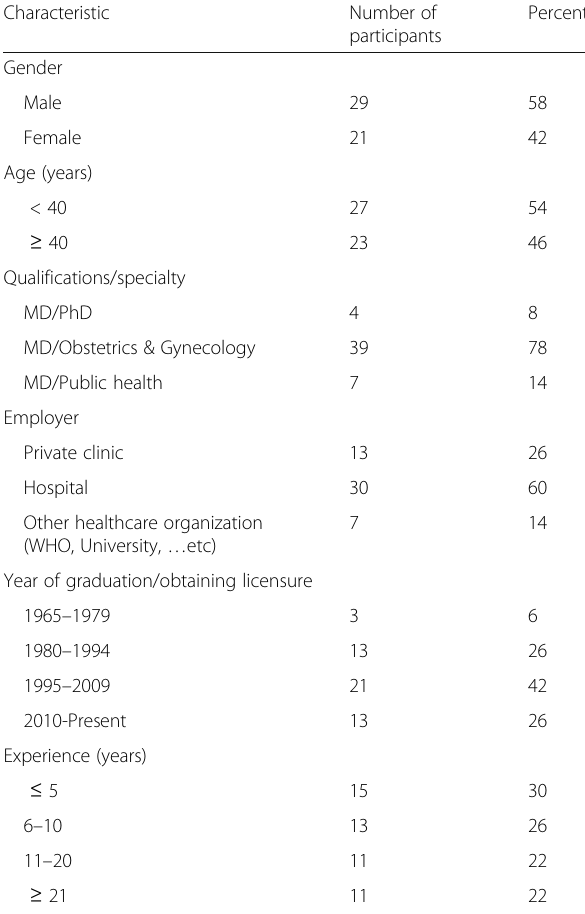
Table 1 Sociodemographic and practice characteristics of the physicians who participated in this study ( n = 50 )